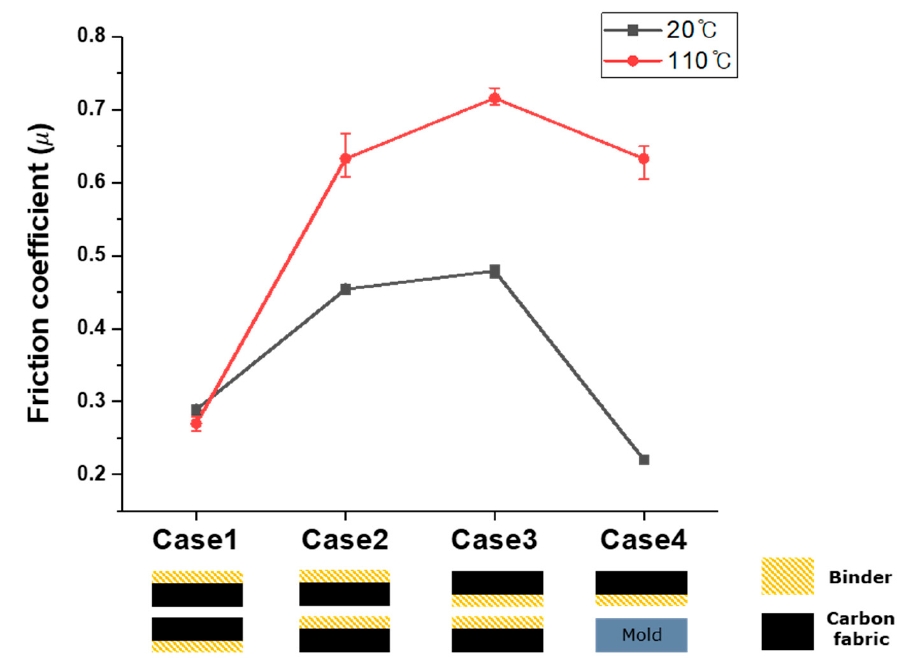
Figure 10. The change in friction coefficient of the carbon fabric as a function of temperature. Table 4. Friction coefficient of the carbon fabric as a function of temperature.